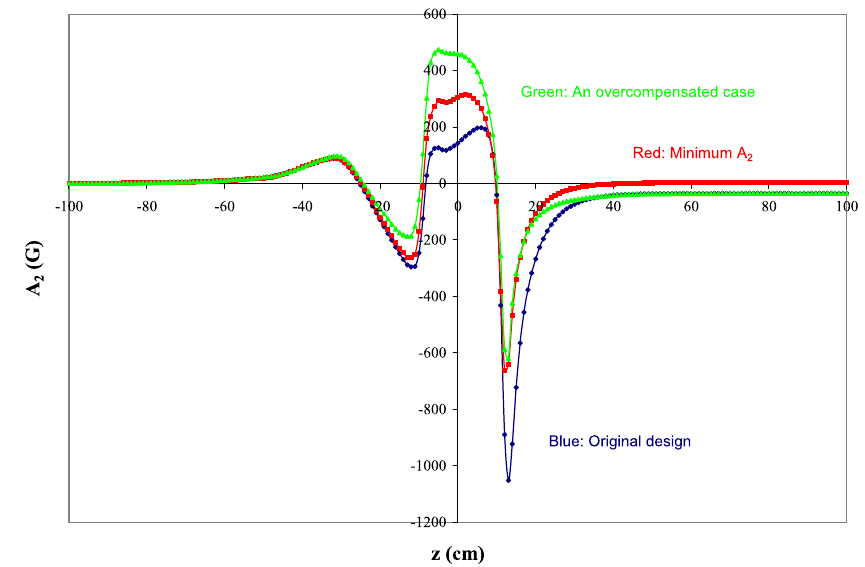
FIG. 17. (Color) Skew quad term along a cylindrical surface of radius R ¼ 8 cm for three